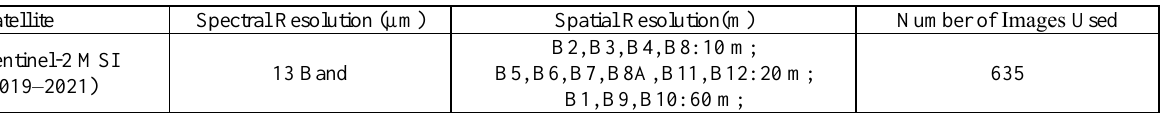
Table 1. Detailed information of satellite images